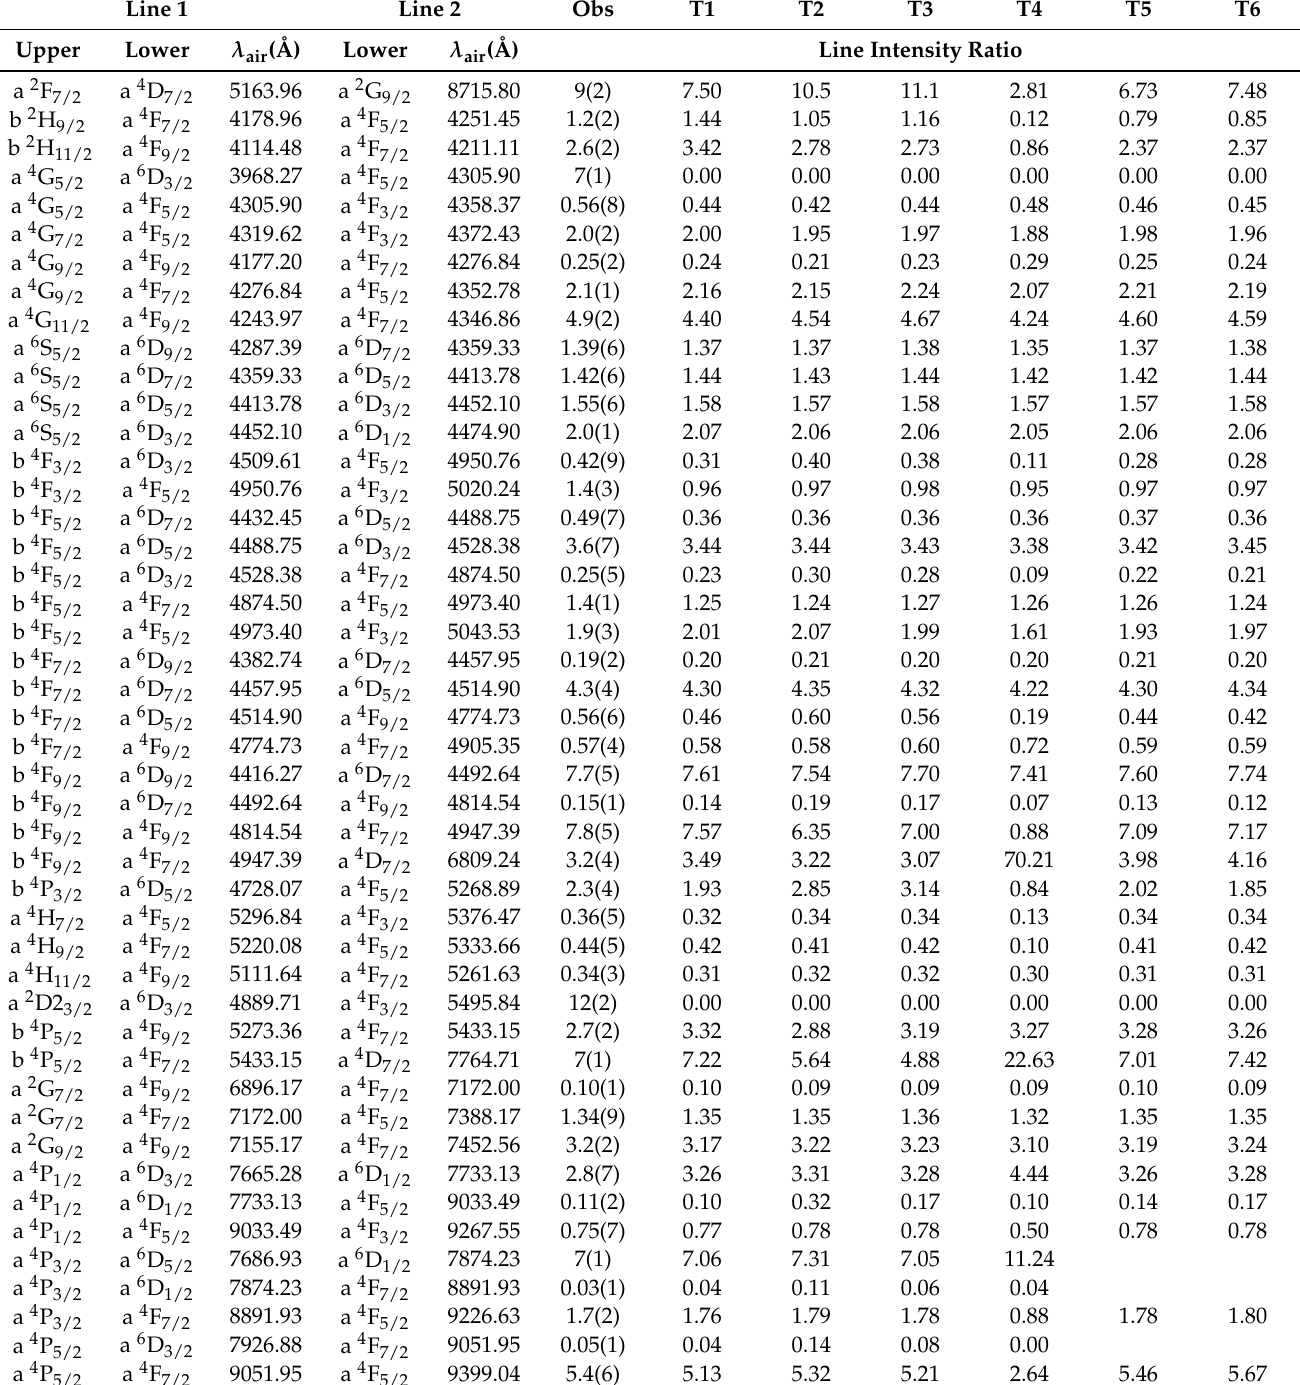
Table 9. Comparison of [Fe II ] line-intensity ratios for transitions arising from a common upper level in the HH204 spectrum (Obs) with those estimated from A -values in the following atom datasets: B15_52 (T1); DH11_52 (T2); TZ18_52 (T3); SRKFB19_52 (T4); QDZa96 (T5); QDZh96 (T6). The error of the least significant figure of the observed intensity ratio is indicated in